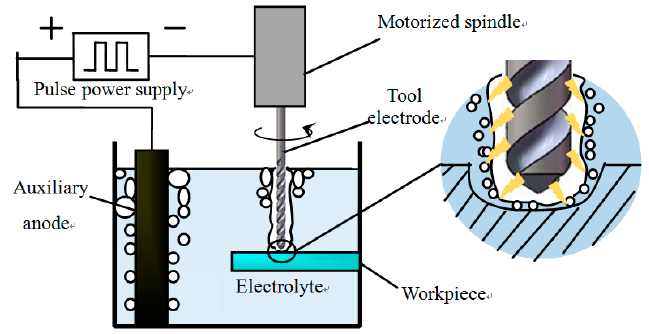
Figure 1. A schematic view of electrochemical discharge machining (ECDM).